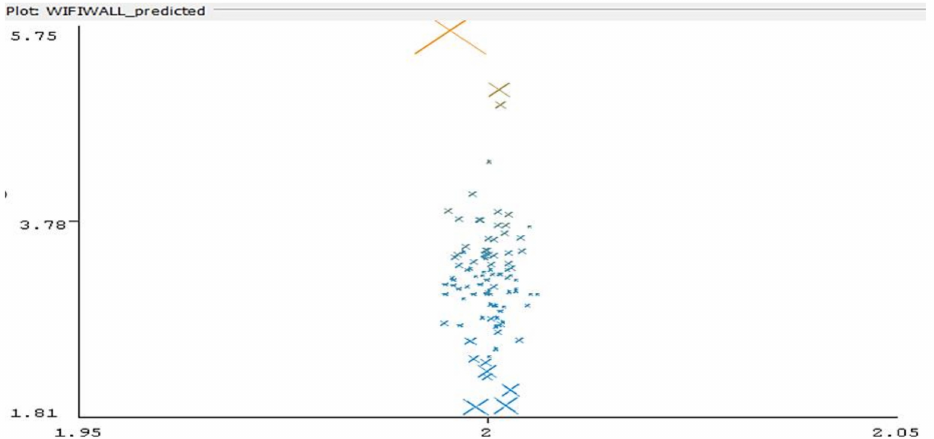
Figure 16. Error distribution in RSSI-based prediction of distance to AP, NLoS scenario—behind an armored concrete wall—colors represent belonging of errors to different clusters, as computed by linear regression algorithm (Vertical axis: predicted distance, horizontal axis: real